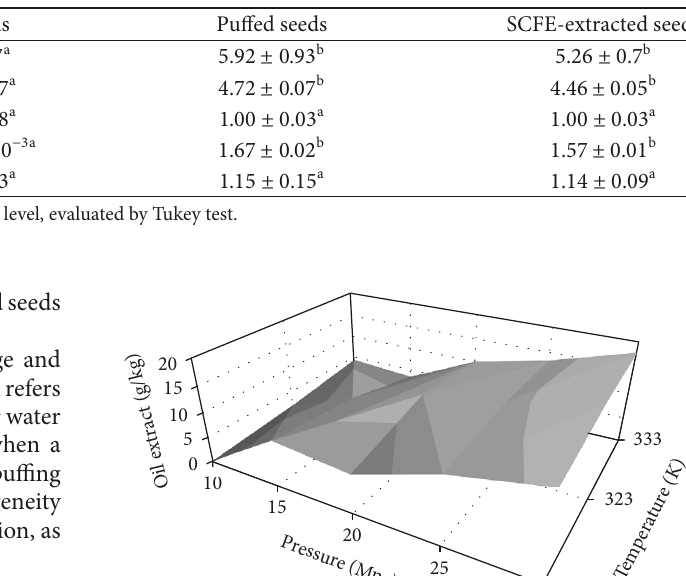
Table 2: Morphology of raw, puffed, and SCFE-extracted A. hypochondriacus seeds.